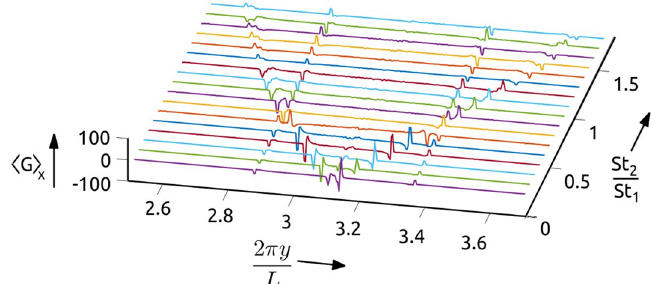
Figure 5. Plots of (cid:31) G (cid:30) x for a bi-disperse system as a function of y and the ratio of the the two particle Stokes numbers, with one of the Stokes number fixed at one ( St 1 = 1.0 ), and varying St 2 . Notice that the peaks in (cid:31) G (cid:30) x corresponding to St 1 are aligned at the same location along y , whereas the peaks due to St 2 show similar trend as the plots for mono-disperse systems in Fig. 4a. This plot was generated in Matlab 2020a, https:// www. mathw orks. com/ produ cts/ matlab. html.